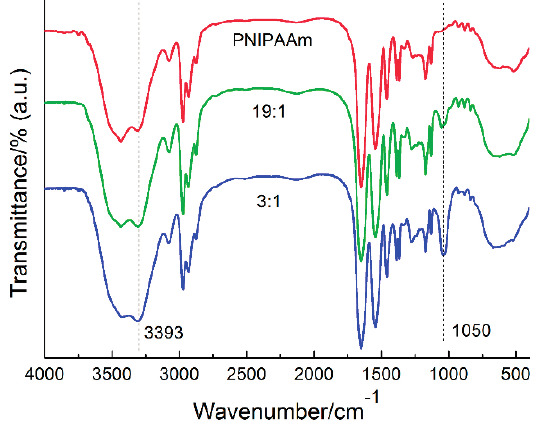
Figure 1. FT-IR spectra of typical P(NIPAAm- co